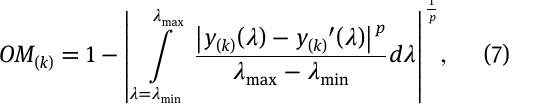
The output O of the DNN is separated into O 1 and O 2